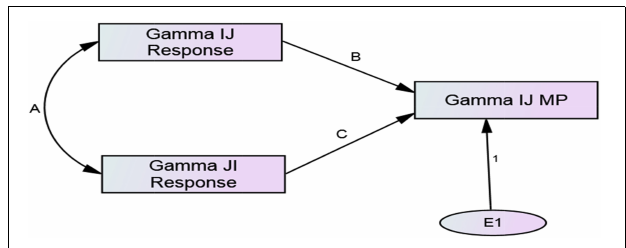
FIGURE 3 | Minimal dyadic ARRMA with incomplete data (gammas are SRM relationship